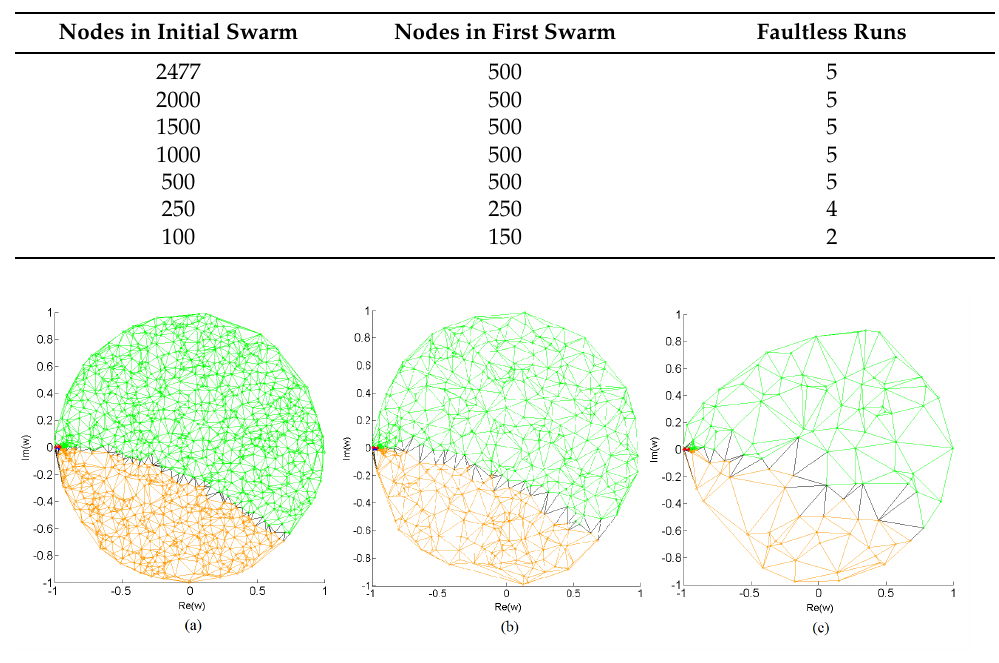
Figure 10. Distribution of nodes with Delaunay’s triangulation for the stability test of a fractional- order digital filter with the use of MPSO-WPA. The results of the stability tests are presented for a number of nodes in the initial and first swarms set, respectively, to ( a ) 1500 and 500, ( b ) 500 and 500, and ( c ) 100 and 150 nodes. The “island”-like region with unstable zero is detected. Phase